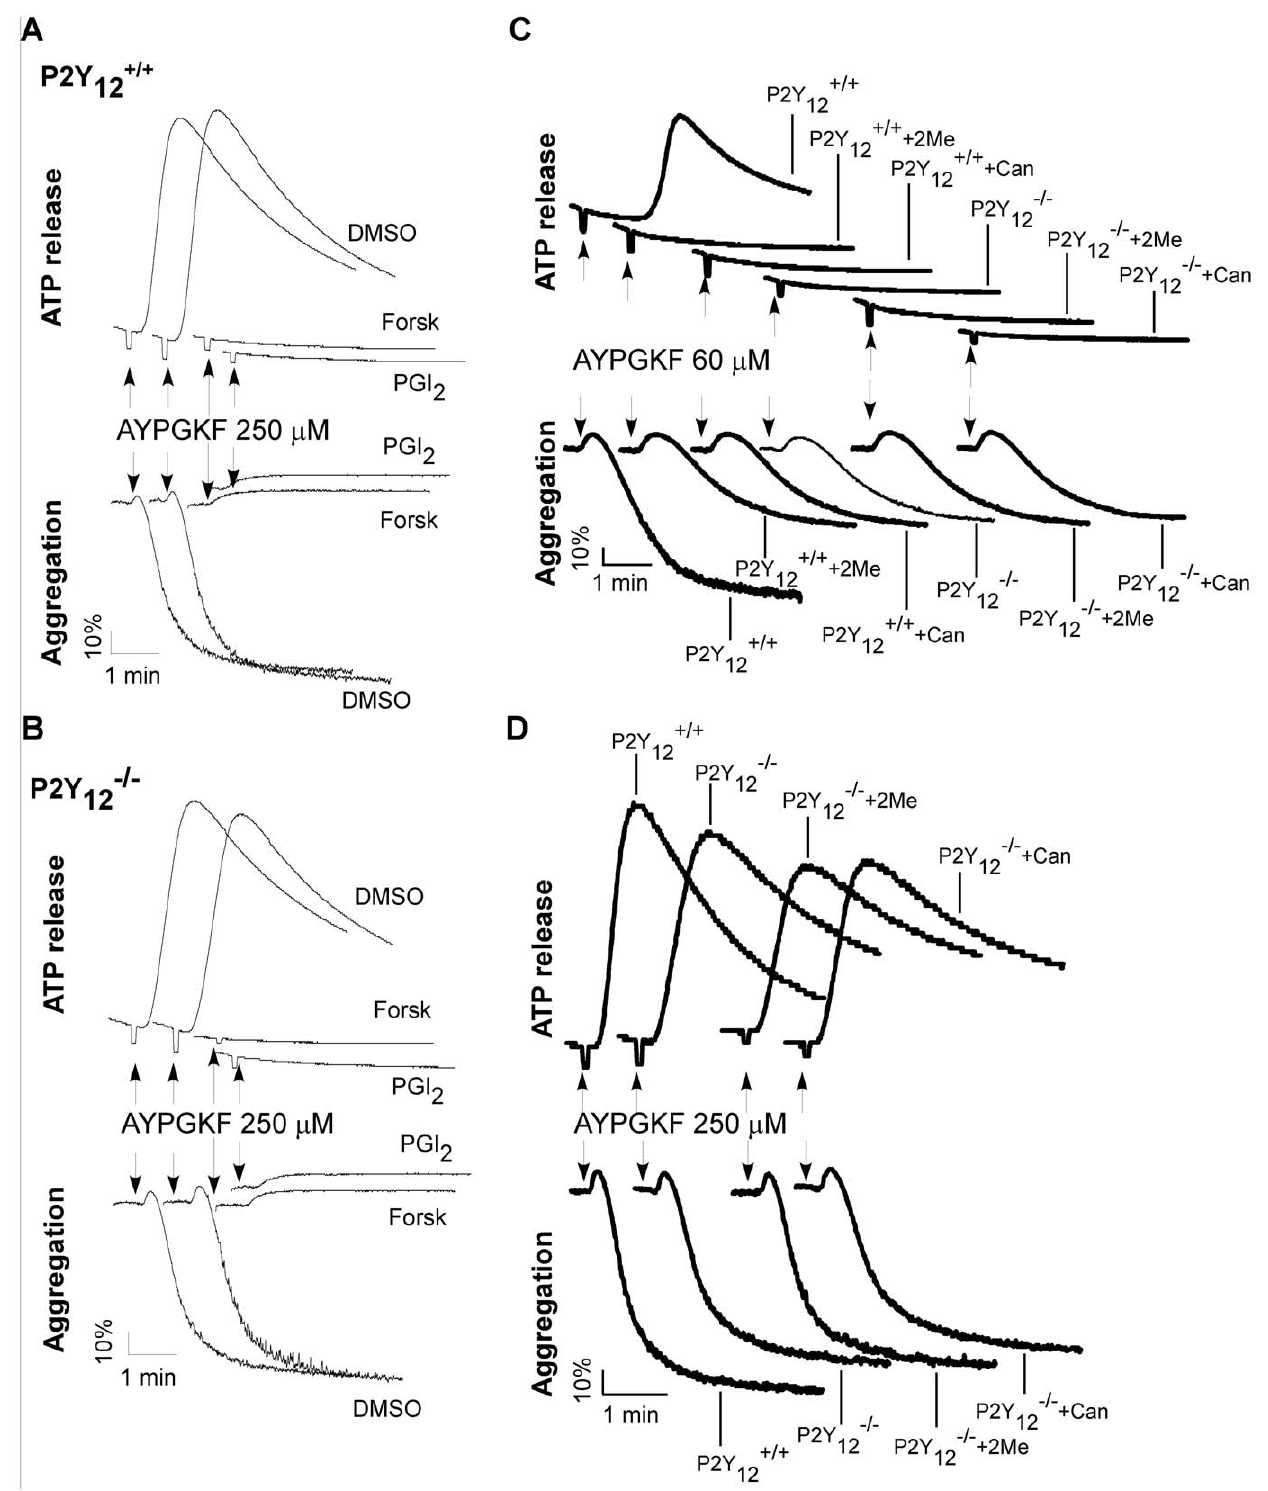
Figure 1. 2MeSAMP and Cangrelor inhibit platelet aggregation and secretion through P2Y 12 -dependent mechanism. (A-B) Washed platelets from wild-type mice (A) or P2Y 12 deficient mice (B) were pre-incubated with PGI 2 (1 m M) or forskolin (10 m M) at 37 u C for 5 min, and added with AYPGKF 250 m M to induce ATP release and aggregation. (C–D) Washed platelets (3 6 10 8 /ml) from P2Y 12 deficient mice and littermate wild-type controls were pre-incubated with Cangrelor (1 m M) (Can) or 2MeSAMP (10 m M) (2Me) at 37 u C for 5 min, and added with AYPGKF 60 m M (C) or 250 m M (D) to induce ATP release and aggregation. Data shown are representative of three independent experiments.